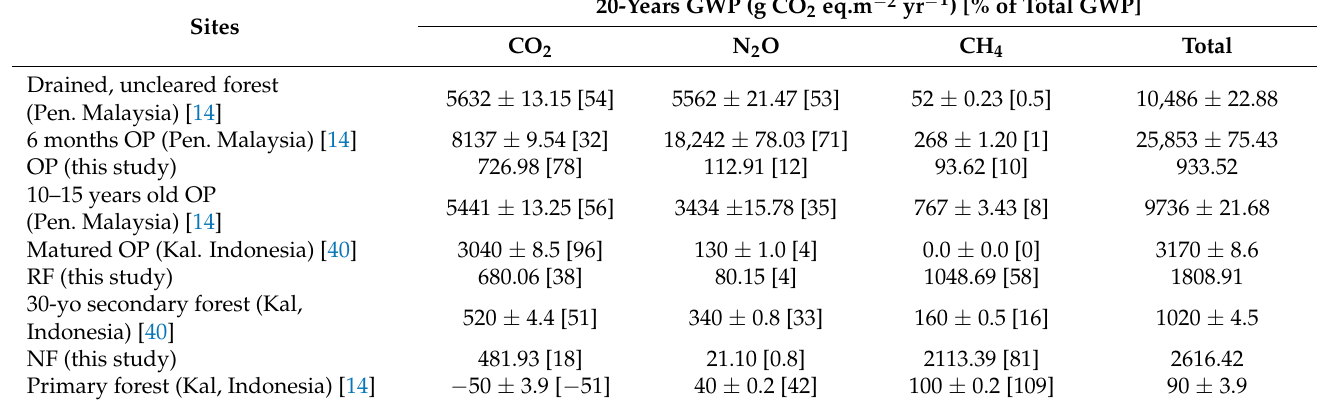
Table 3. 20-year GWP of Annualized emissions (g CO 2 eq.m − 2 yr − 1 ) of peatland sites in the current study and published results from other